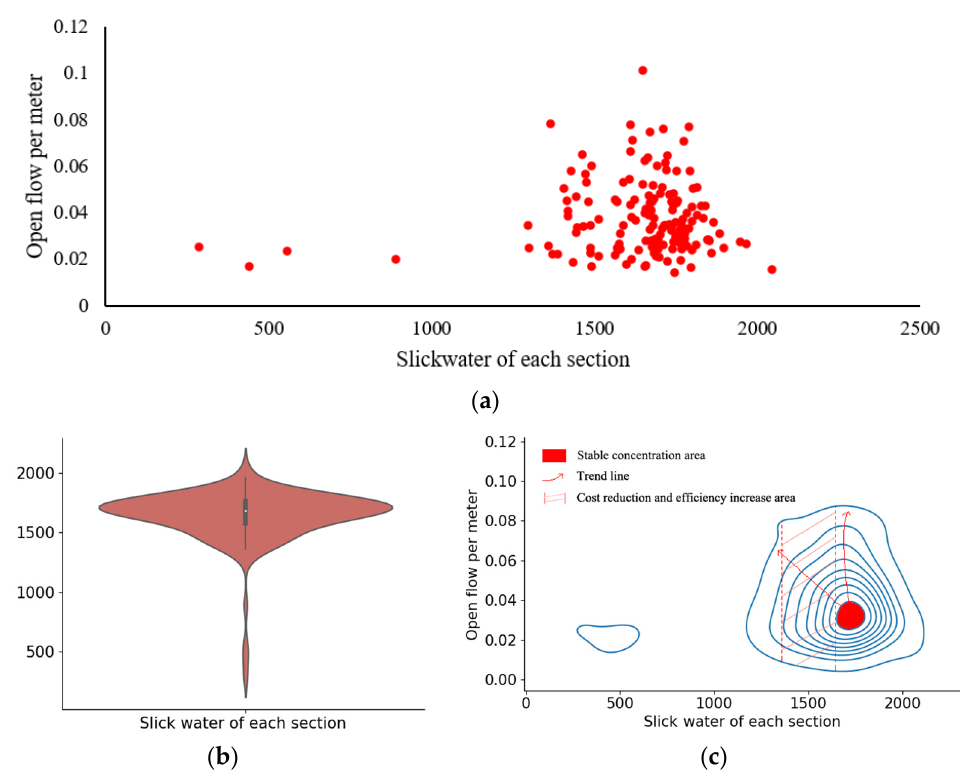
Figure 5. Analysis of slickwater data. ( a ) Scatter plot of slickwater; ( b ) violin plot of slickwater; ( c ) binary KDE plot of slickwater.